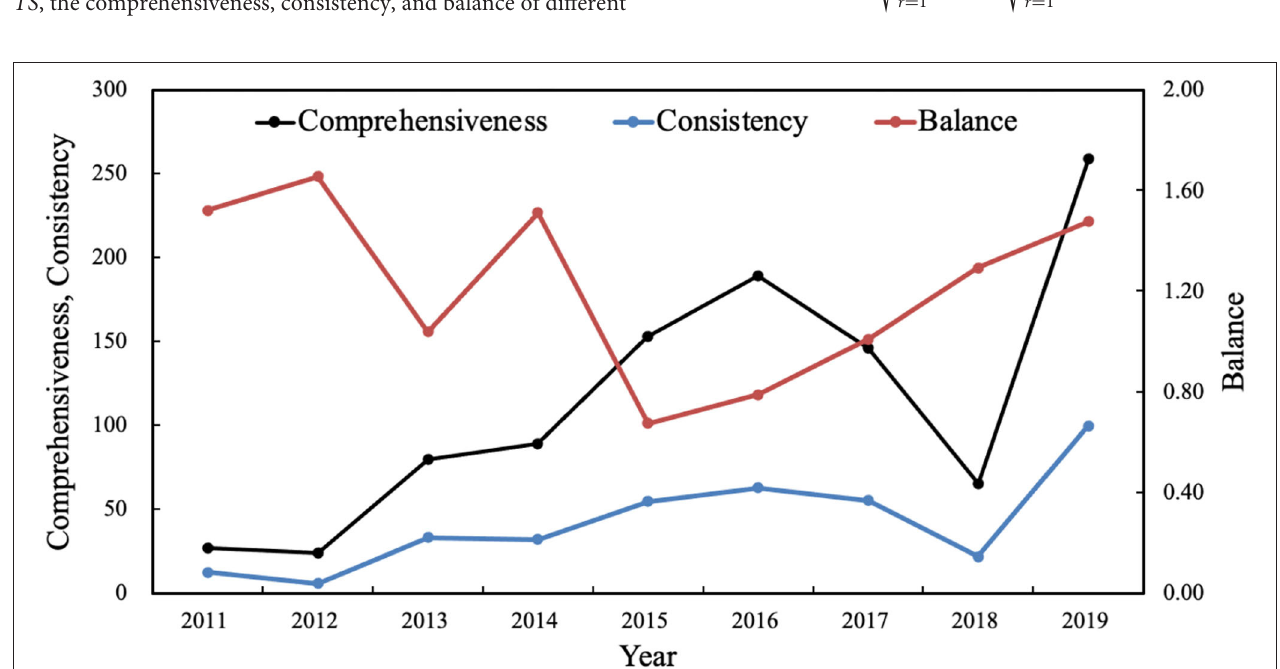
FIGURE 1 | Characteristic trends of policy instrument mix of institutional care for older people in 2011–2019.